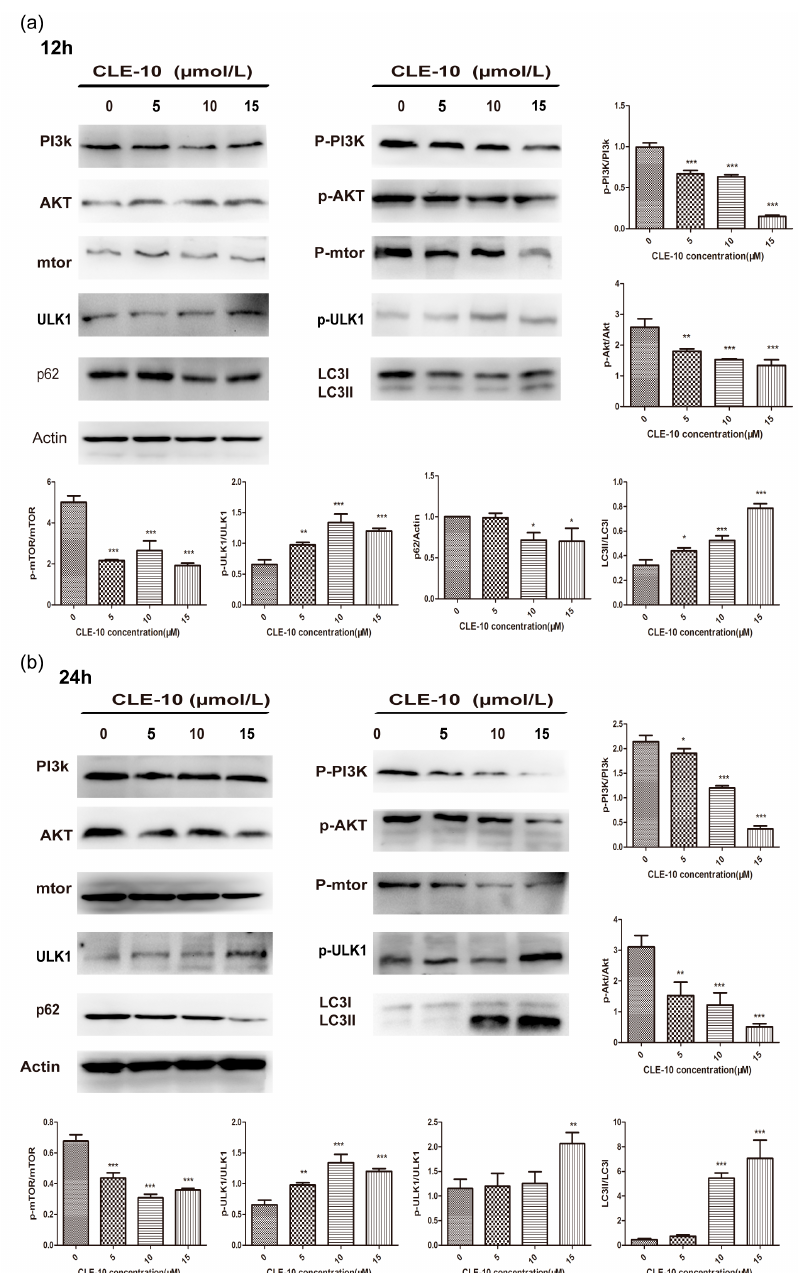
Figure 6. Influence of CLE-10 on the expression of the PI3K/Akt/mTOR signal pathway and autophagy-related proteins. ( a ) After 12 h of treatment with CLE-10, PI3K, Akt, mTOR, p-PI3K, p-Akt, p-mTOR, ULK1, p-ULK1, p62, LC3-I, and LC3-II expressions in MDA-MB-231 cells were analyzed by Western blot. ( b ) After 24 h of treatment of CLE-10, PI3K, Akt, mTOR, p-PI3K, p-Akt, p-mTOR, ULK1, p-ULK1, p62, LC3-I, amd LC3-II expressions in MDA-MB-231 cells were detected by Western blot. Data are expressed as the mean ± SD ( n = 3). (* p < 0.05, ** p < 0.01, *** p < 0.001 compared with the 0 µM CLE-10 group).